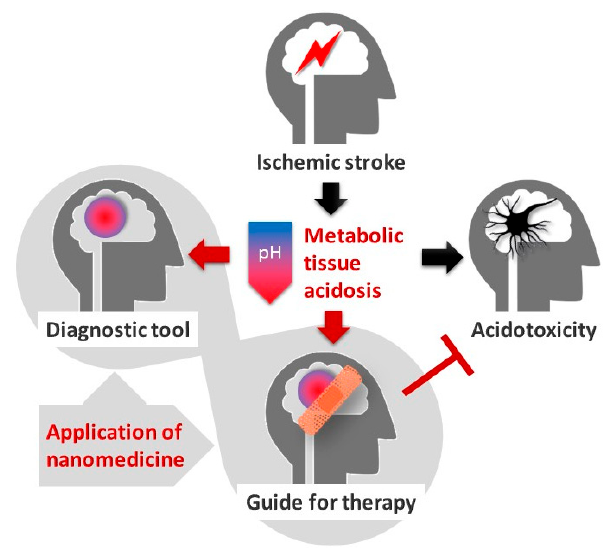
Figure 1. The stroke-associated metabolic acidosis of the nervous tissue, which is lethal to neurons above a critical threshold (“Acidotoxicity”), may be harnessed for the accurate identification of the ischemic penumbra (“Diagnostic tool”), or for focusing drug delivery selectively to the ischemic penumbra (“Guide for therapy”) with smart nanosystems.